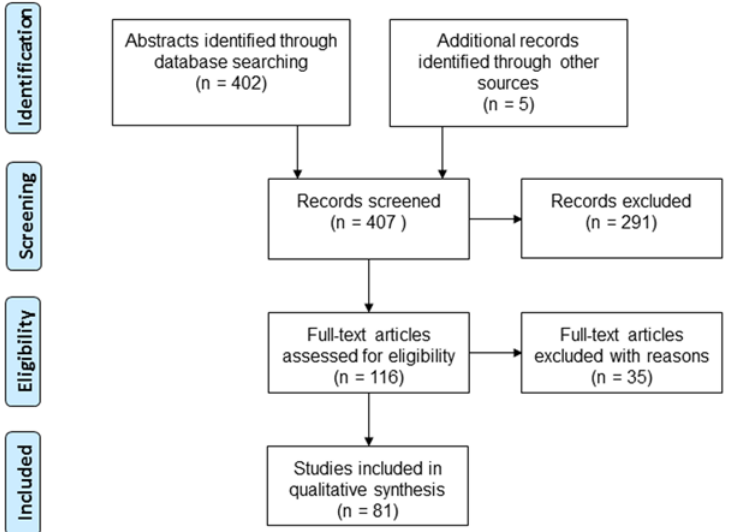
Fig 1. Flow diagram showing the literature search strategy. Flow diagram chart showing the literature search strategy with the number of retrieved abstracts, included and excluded articles.